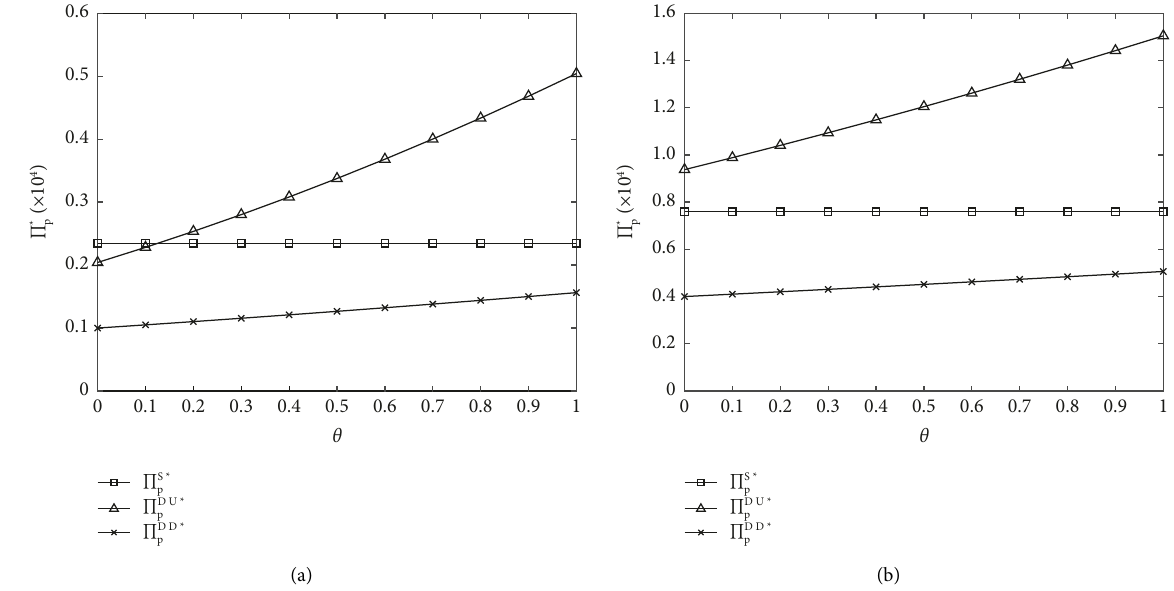
Figure 5: Comparison of optimal e-platform’s profits among three models: (a) Δ � 200; (b) Δ � 400.